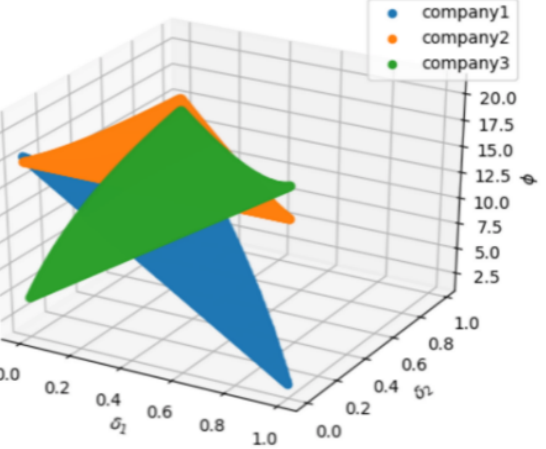
Figure 5. The variation of the result of profit distribution with the weight of each